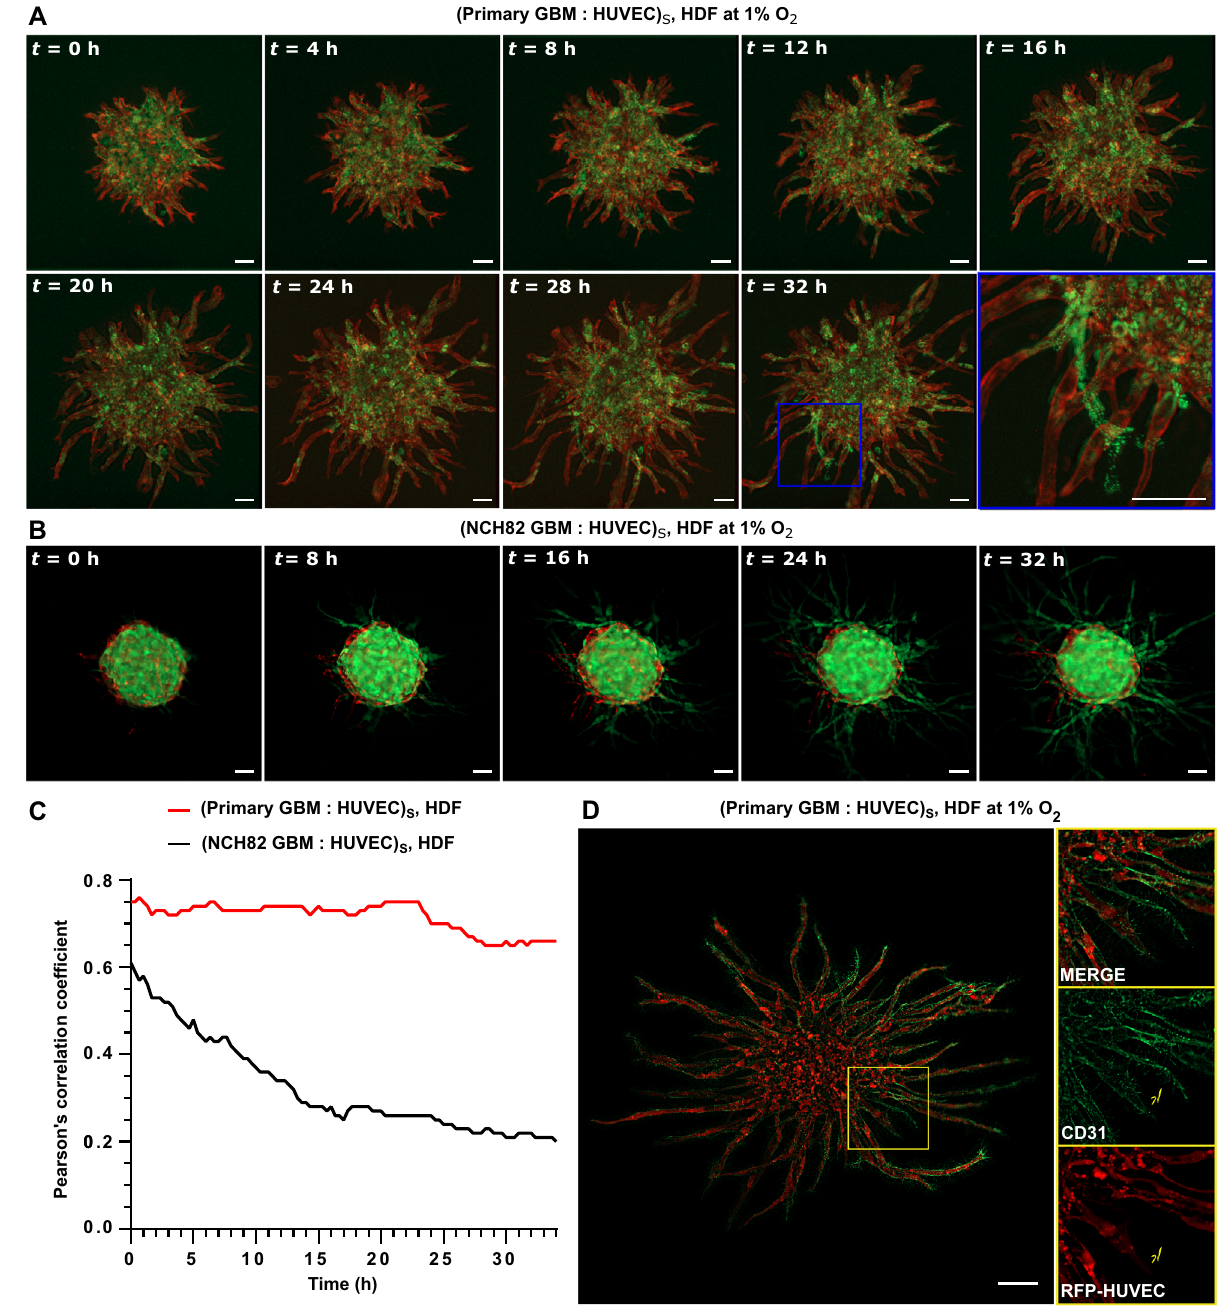
Figure 4. Time-lapse imaging showing evolution of GBM: HUVEC spheroid with HDF as the supporting cell at 1% O 2 over a period of 32 h. ( A ) Primary GBM (green) : HUVEC (red) spheroid. ( B ) NCH82 GBM (green) : HUVEC (red) spheroid. t = 0 h is taken at day 1 after seeding. HDF cells are non-fluorescent. The spheroids and single HDF cells are embedded in a 7.5 mg/mL fibrin gel. ( C ) Plot showing Pearson’s correlation coefficient as a function of culture time. Similar results were obtained in three independent experiments. ( D ) CD31 immunohistochemical staining (green) of primary GBM : HUVEC spheroid at day 3 after seeding. Right images are magnified views of the selected area (yellow box). The scale bars represent 100 µ m. Subscript S denotes cells seeded in the same